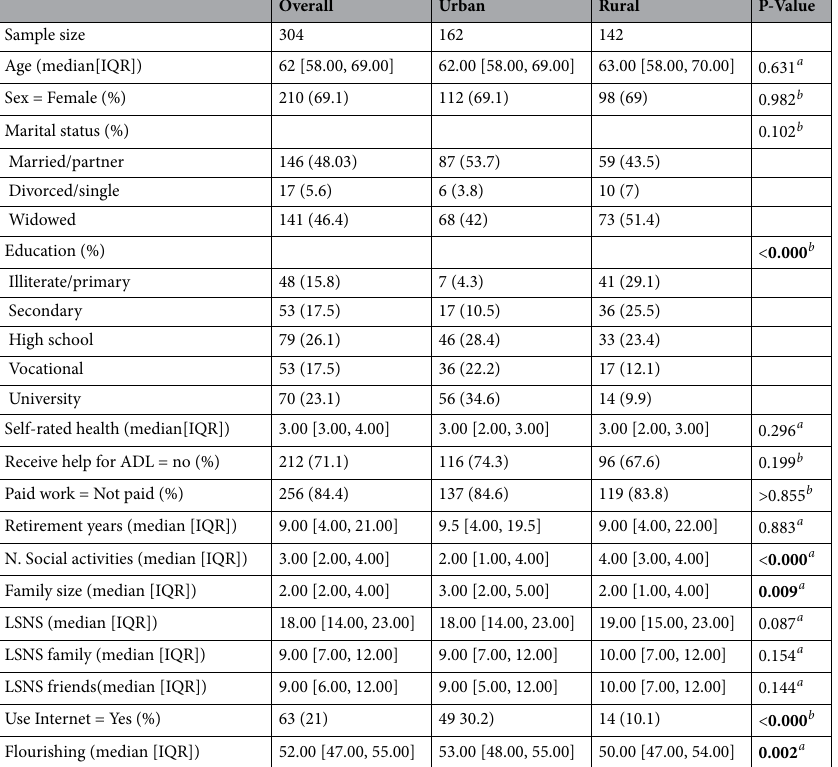
Table 2. Descriptive statistics. Difference between samples computed using (a) Kruskal-Wallis for continuous variables non normally distributed, and (b) Pearson Chi-squared test for categorical